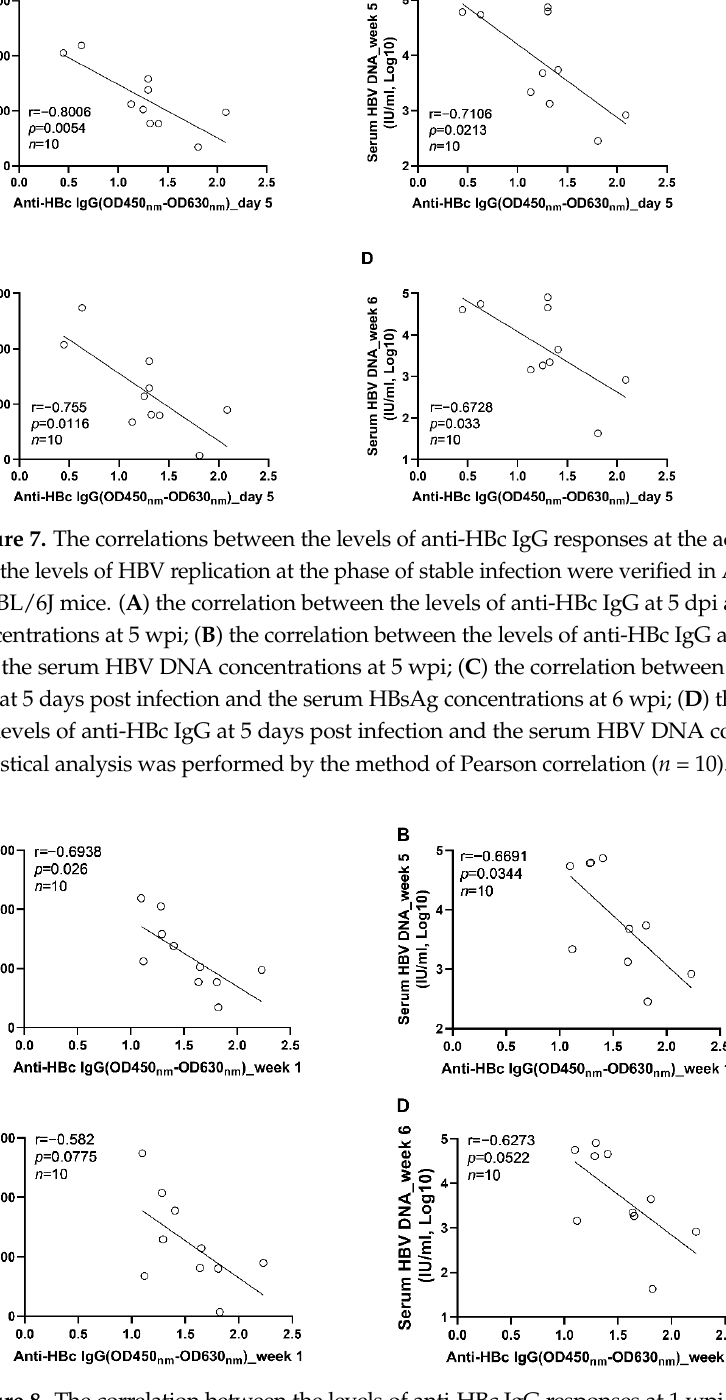
Figure 8. The correlation between the levels of anti-HBc IgG responses at 1 wpi and the levels of HBV replication at the phase of stable infection in C57BL/6J mice; ( A ) the correlation between the levels of anti-HBc IgG at 1 wpi and the serum HBsAg concentrations at 5 wpi; ( B ) the correlation between the levels of anti-HBc IgG at 1 wpi and the serum HBV DNA concentrations at 5 wpi; ( C ) the correlation between the levels of anti-HBc IgG at 1 wpi and the serum HBsAg concentrations at 6 wpi; ( D ) the correlation between the levels of anti-HBc IgG at 1 wpi and the serum HBV DNA concentrations at 6 wpi. Statistical analysis was performed by the method of Pearson correlation ( n =